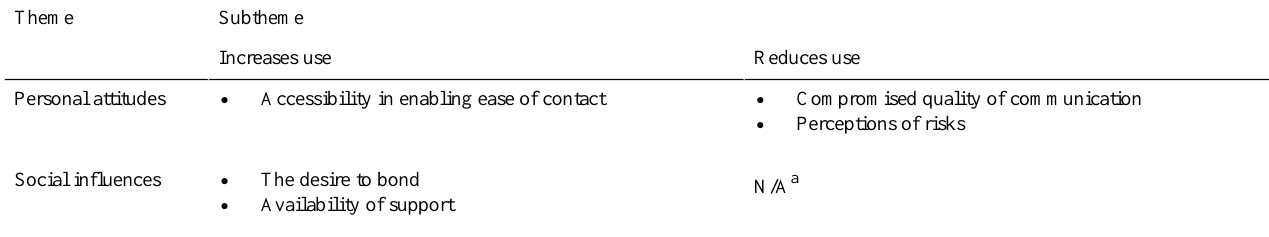
Table 2. Overview of themes and subthemes: older adults’experience in their use of social media